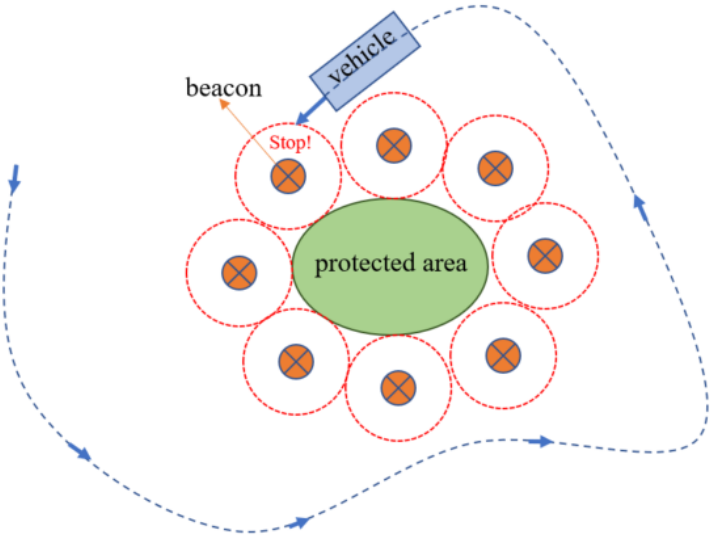
Figure 2. Using passive beacons to delineate a no-entry